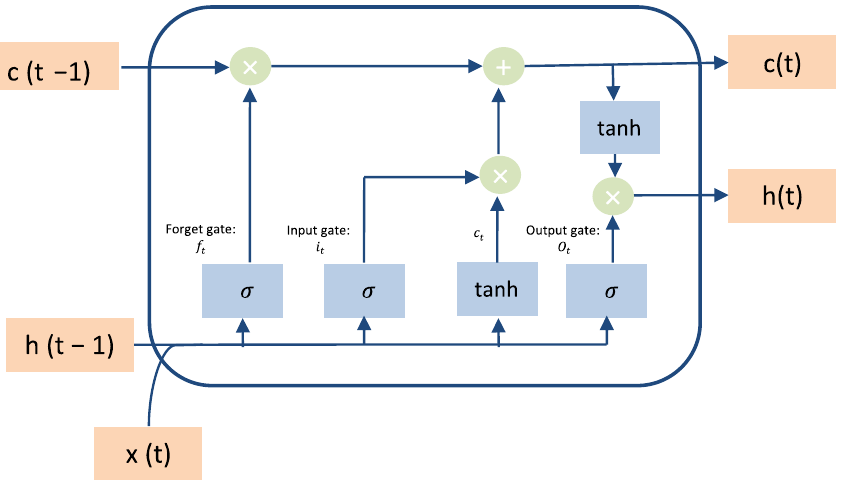
Figure 3. LSTM cell architecture.